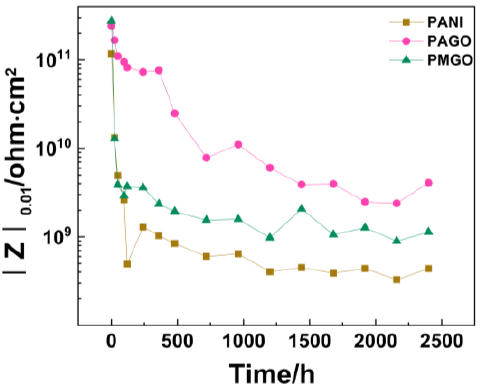
Figure 7. Low-frequency impedance value of the three coatings versus time Figure 7. Low ‐ frequency impedance value of the three coatings versus time .